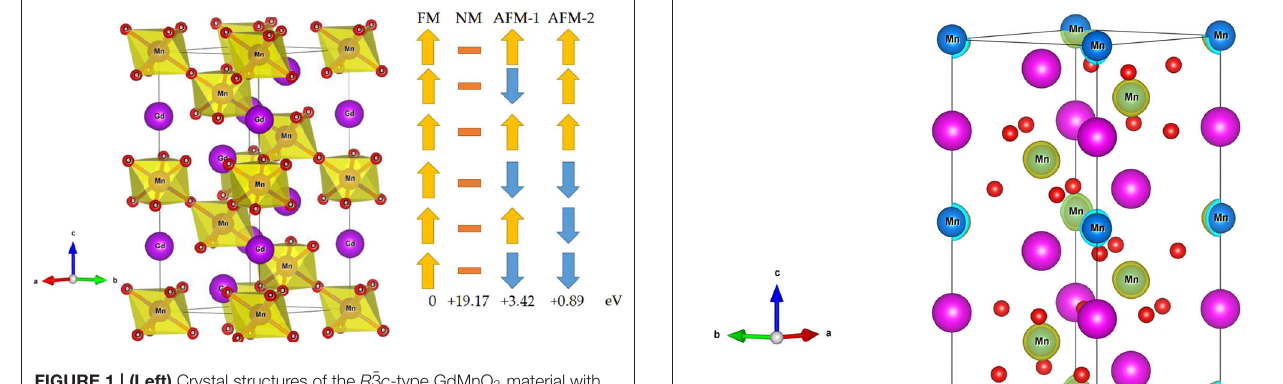
FIGURE 1 | (Left) Crystal structures of the R ¯ 3 c -type GdMnO 3 material with hexagonal structure; (Right) four magnetic structures, i.e., FM, NM, and two AFM structures (labeled as AFM-1, and AFM-2).